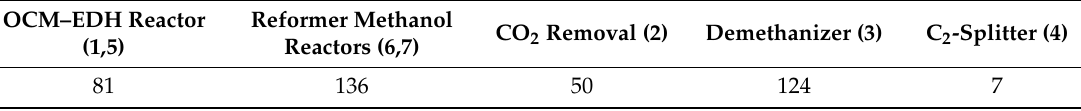
Table 6. The cost items in different sections of the selected OCM process scenario (all in (€/t C 2 H 4 ) and according to the section numbers in Figure 1).